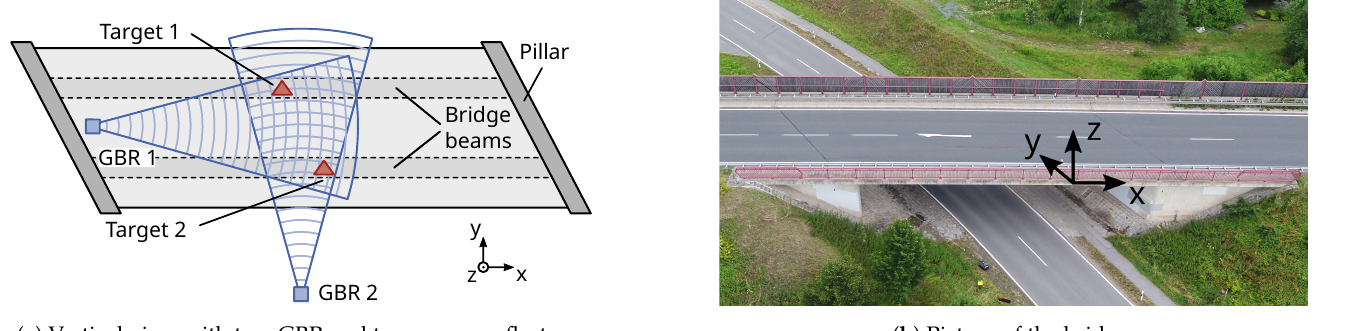
Figure 8. Measurement setup at Schneckenlohe (Germany) on 22 October 2019.